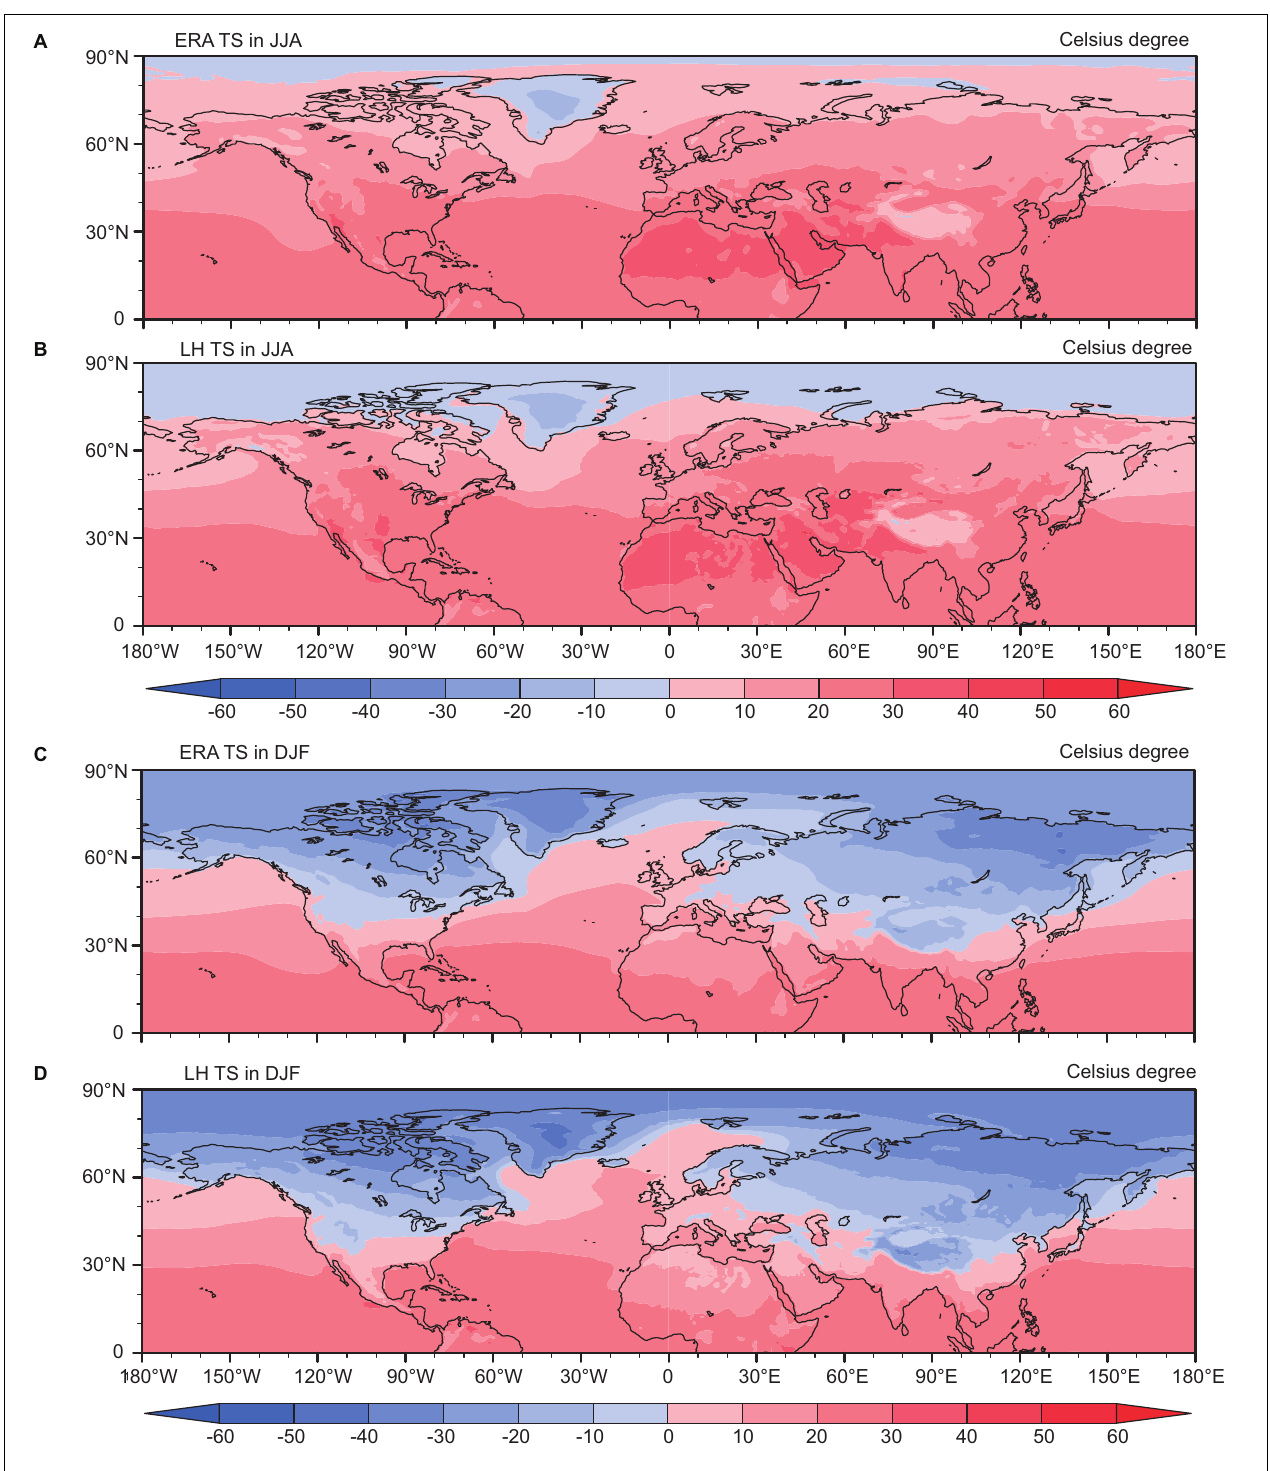
FIGURE 1 | Northern Hemisphere surface temperature ( ◦ C). The ERA-Interim reanalysis data for 1979–2014 (A,C) , and the simulated results averaged for 1-0 ka BP (B,D) .